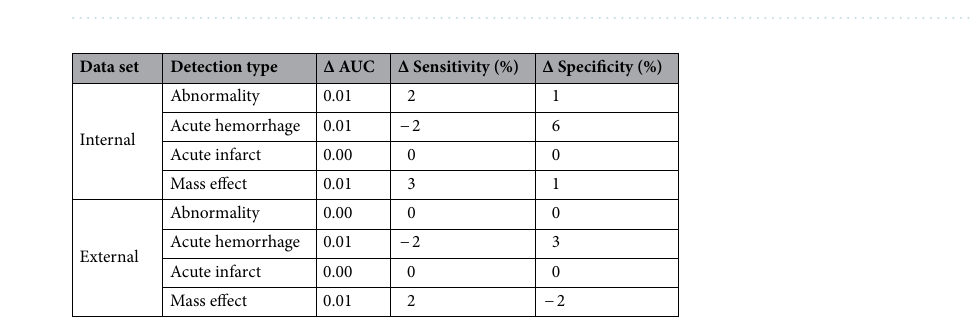
Figure 5. Examples of heat maps provided by the network for detection of acute intracranial hemorrhage. ( A ) Heatmap on axial FLAIR shows correct identification of intraparenchymal hemorrhage (true positive). ( B ) Subarachnoid hemorrhage seen as sulcal hyperintense signal on axial FLAIR image (arrows) was not detected by the network (false negative). ( C ) Heatmap on axial FLAIR points to periventricular leukomalacia (arrow) (false positive).